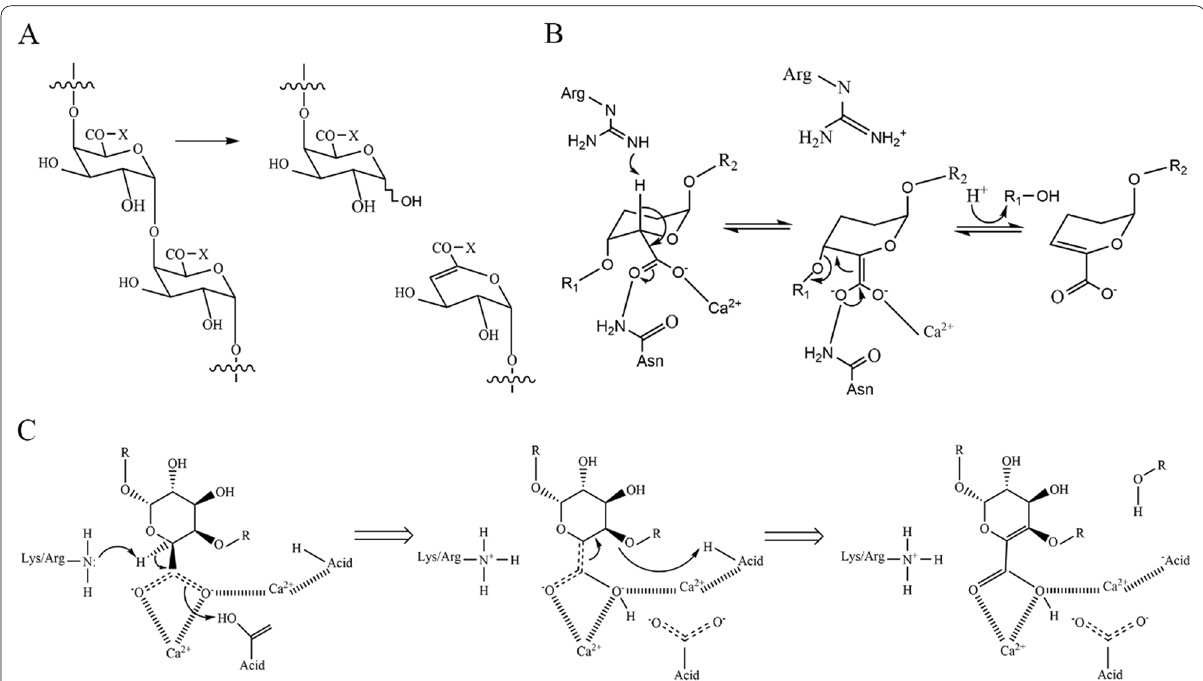
Fig. 4 The β-elimination catalytic mechanism of PGLs. A. Mode of action in PGLs and PMGLs (X: –O–, the substrate is pectinate, X: –O–CH3, the substrate is pectin); B. Ca 2 + -assisted β-elimination catalytic mechanism; C. Common β-elimination catalytic mechanism in PGLs and PMGLs (Lys/Arg as catalytic